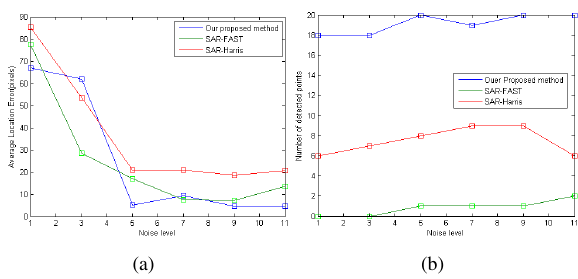
Figure 5. The performence of three detectors on simulated SAR images of different noise levels. (a) The localization errors versus the noise level. (b) The number of correcly detected points versus the noise level.